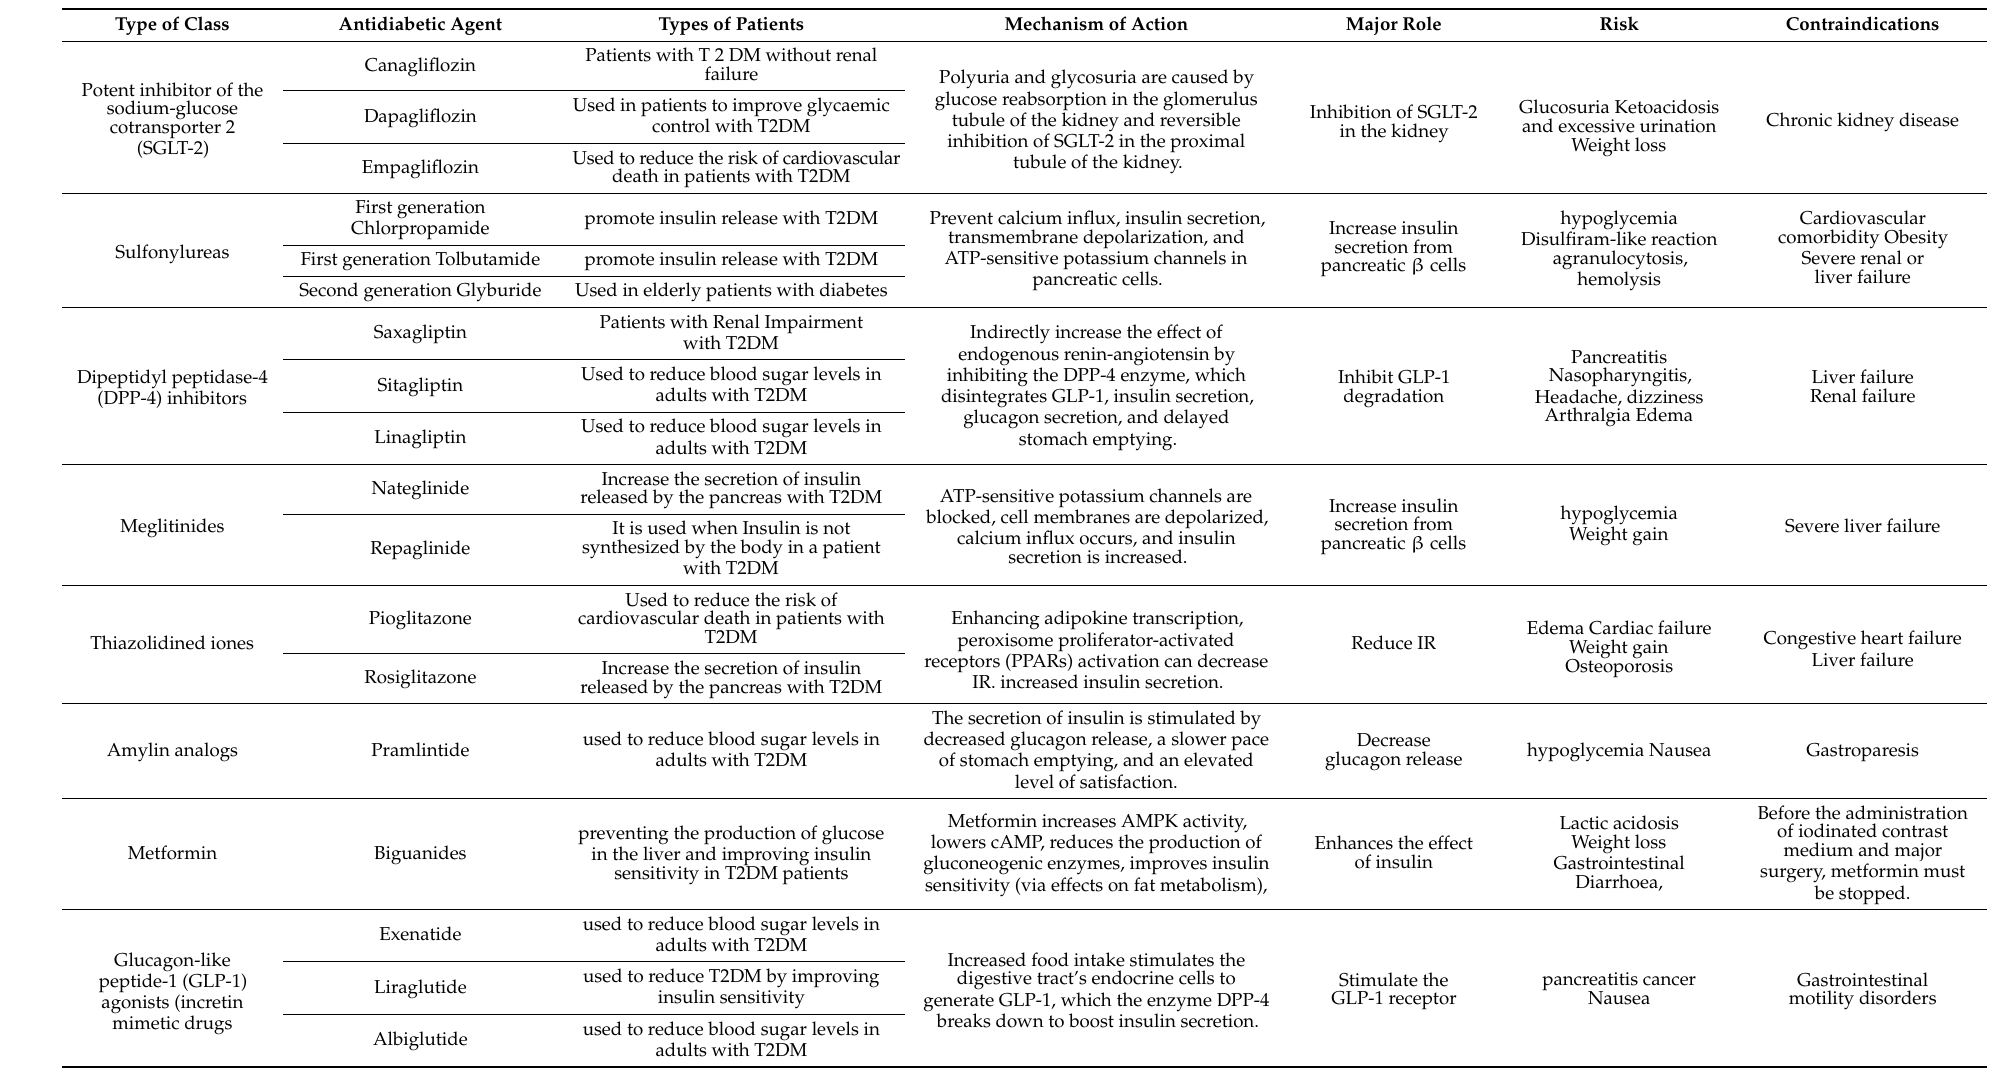
Table 2. Antidiabetic drug list, including mechanisms of action, significance, and risk